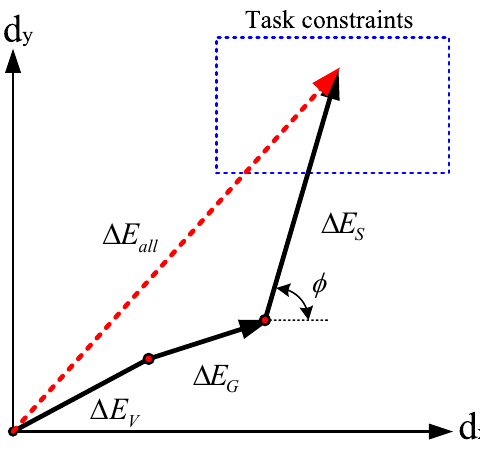
Figure 13. Vector representation of Cartesian position